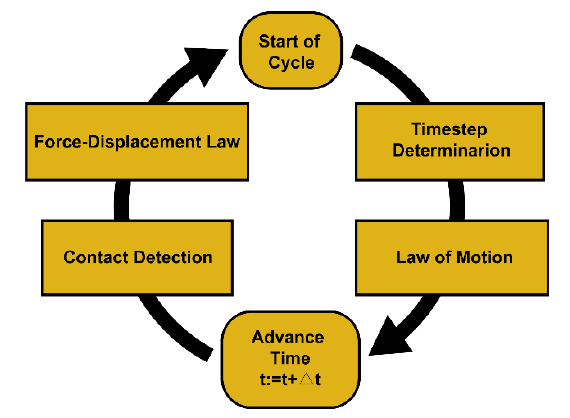
Figure 1. Computational cycle of the discrete element method.